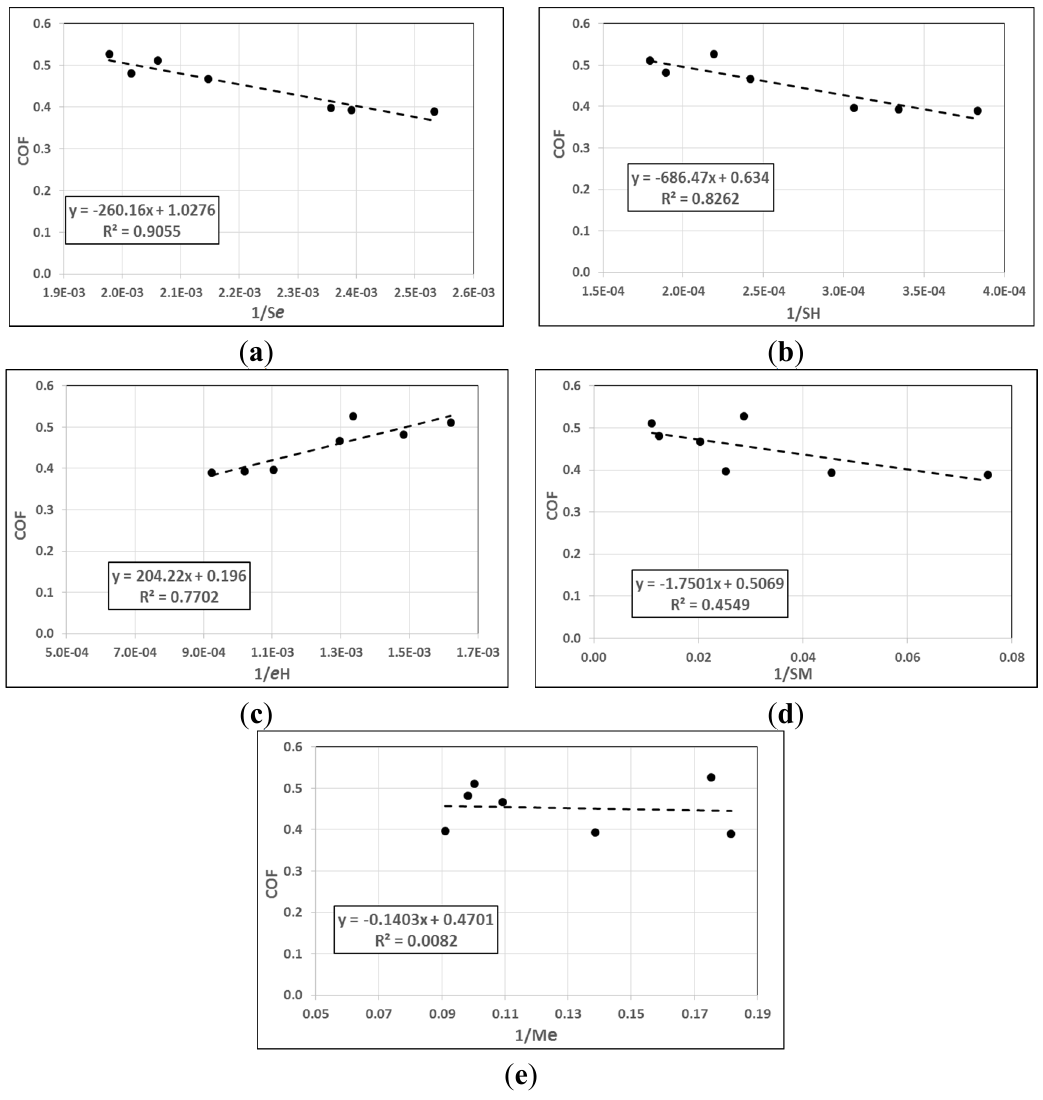
Figure 7. Correlation between the combined mechanical properties and COF of the materials. ( a ) ( S e ) − 1 ; ( b ) ( SH ) − 1 ; ( c ) ( e H ) − 1 ; ( d ) ( SM ) − 1 ; ( e ) ( M e ) − 1